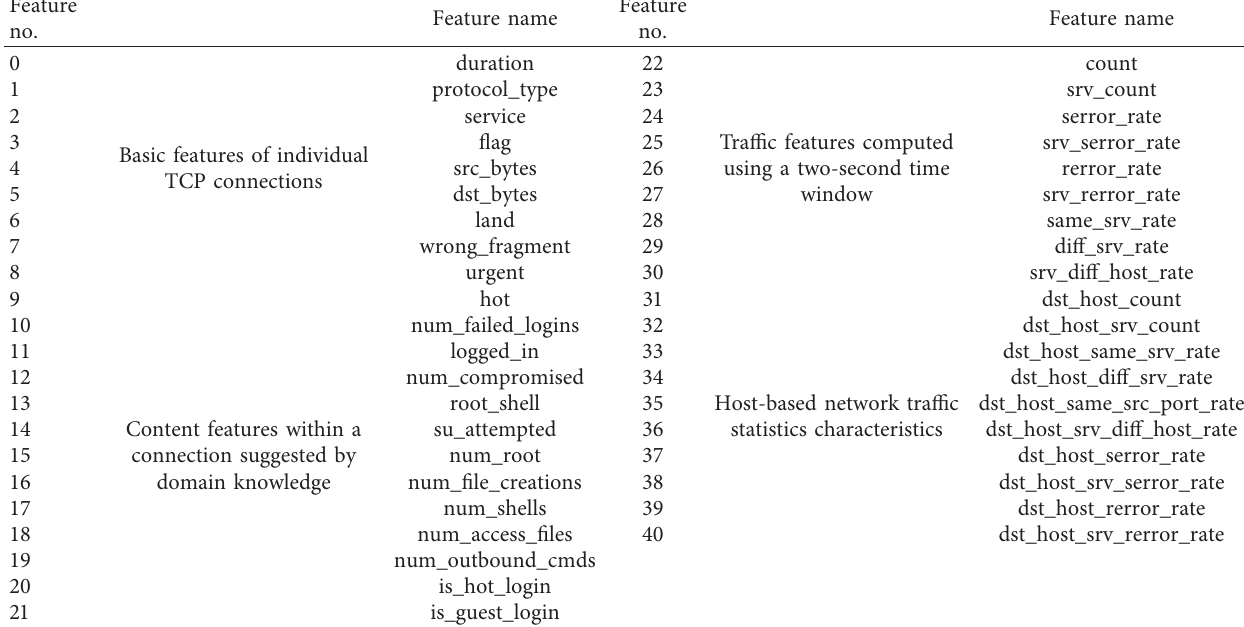
Table 1: Characteristics of KDD CUP 99 dataset.